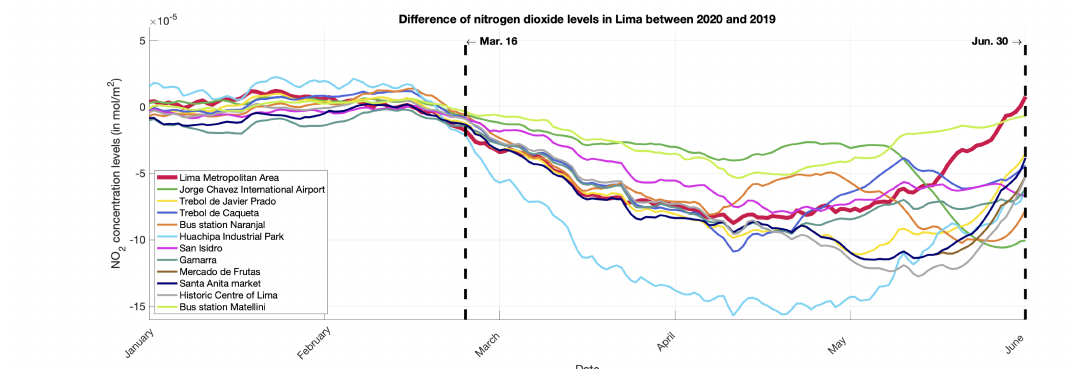
Figure 7. Nitrogen dioxide pollution differences between 2019 and 2020, from the range of 1 January to 4 July, when available, for the zones indicated in Figure 5.